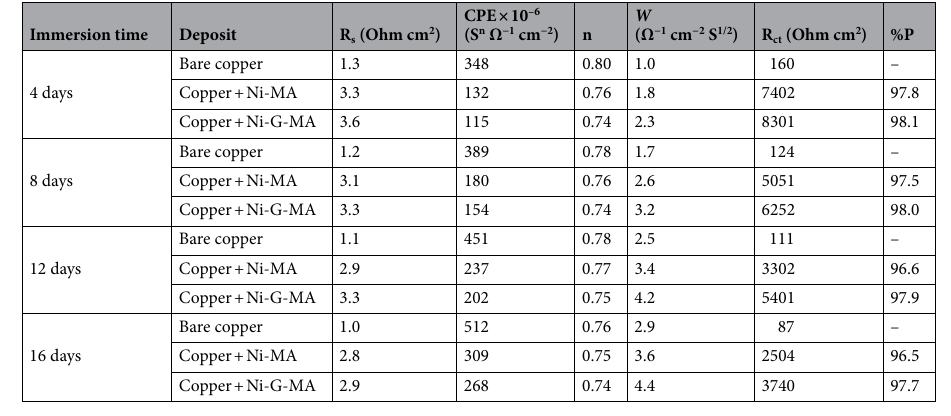
Table 3. EIS parameters for bare and SHP coated copper immersed in 0.5 M NaCl solution for 4 days.